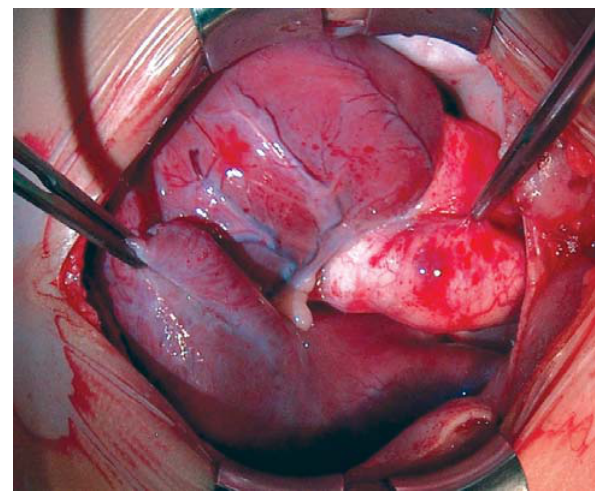
Fig. 4 – Átrio posicionado à esquerda sendo tracionado pela pinça com características anatômicas externas que lembram o átrio direito